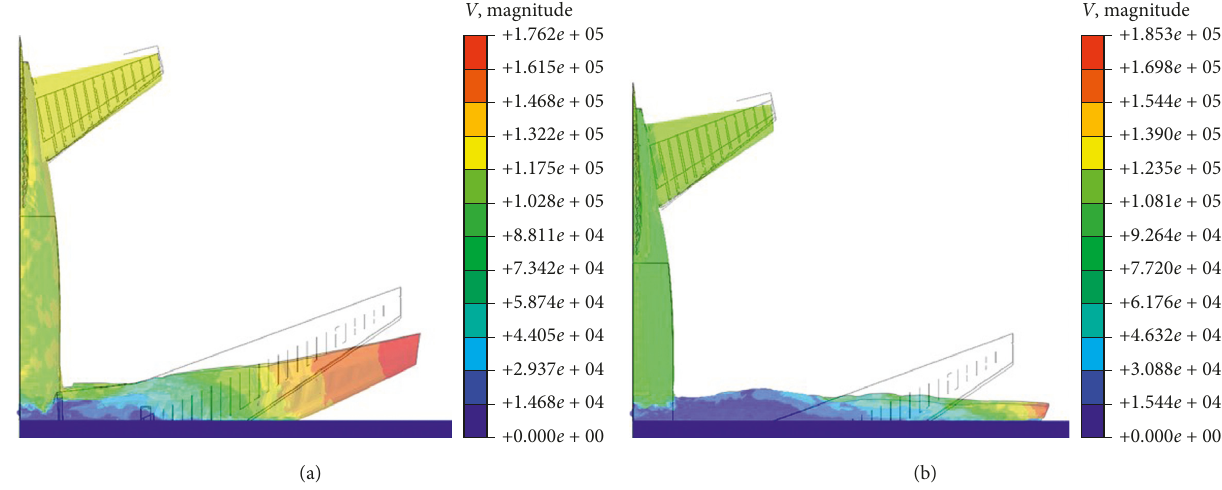
Figure 6: Snapshots of Boeing 767-200ER hitting on a rigid wall. (a) 0.175 s. (b) 0.200s.